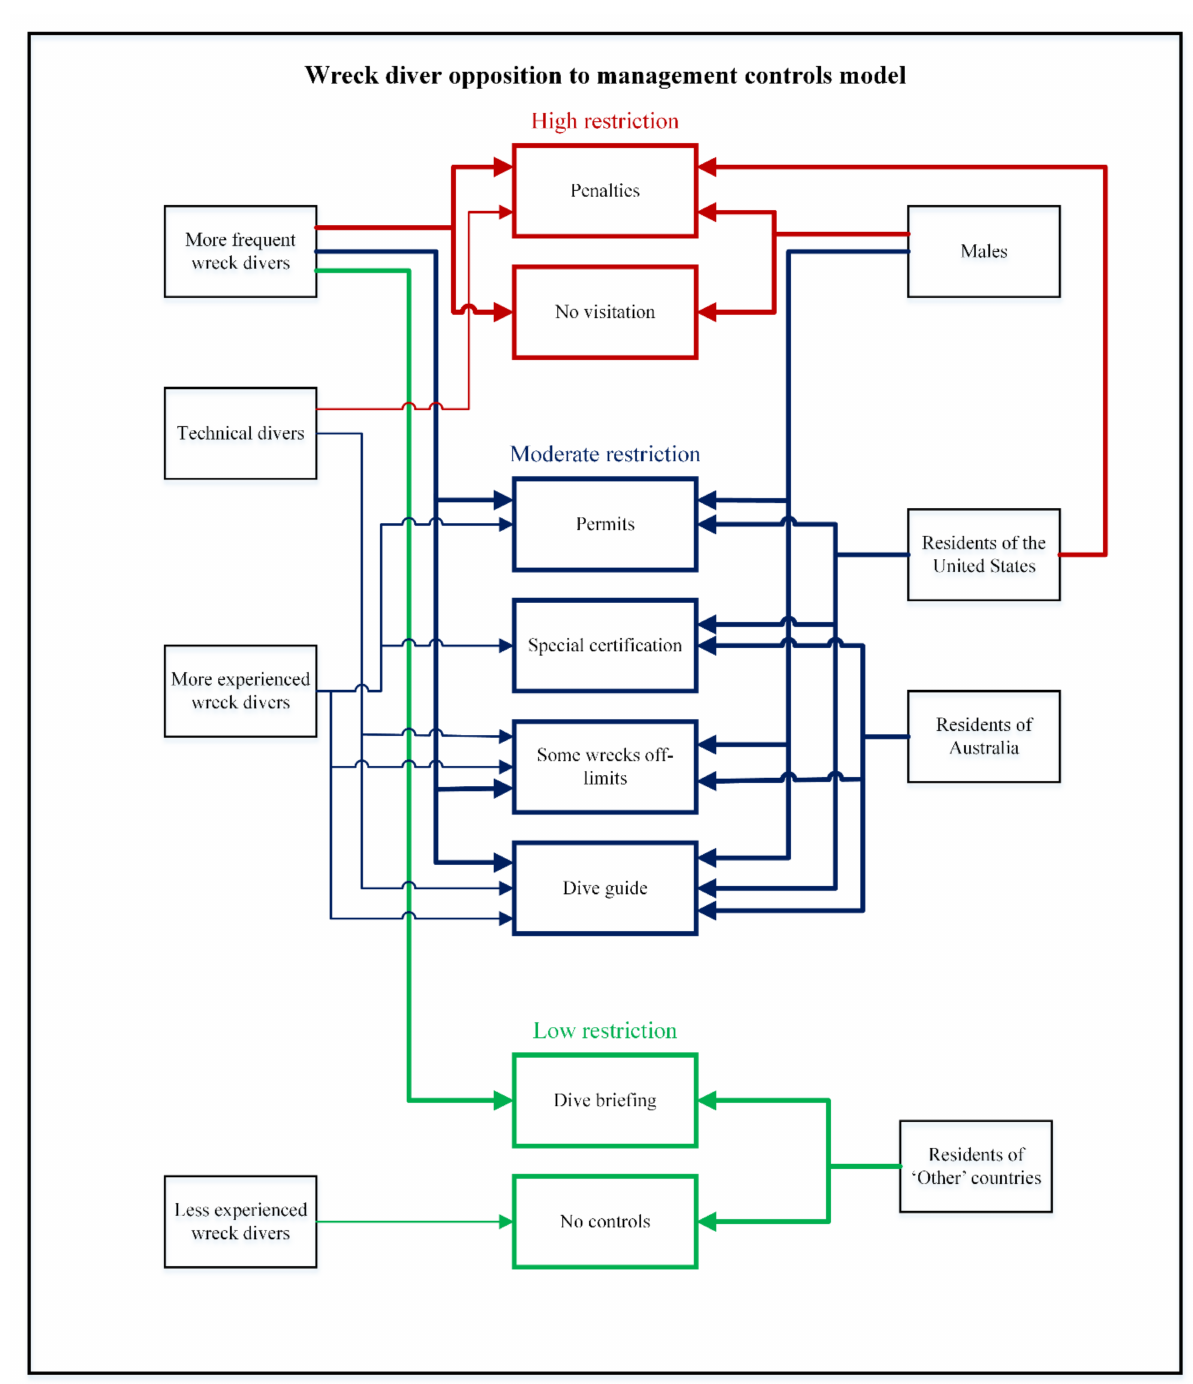
Figure 8. Wreck diver opposition to controls model—adapted from [37] (p.